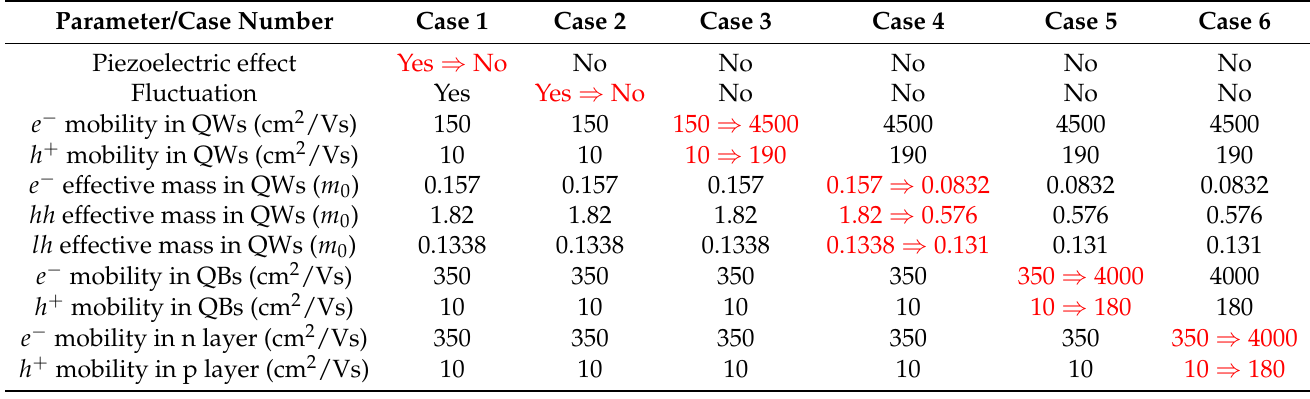
Table 3. Comparison of the parameters in cases 1–6.